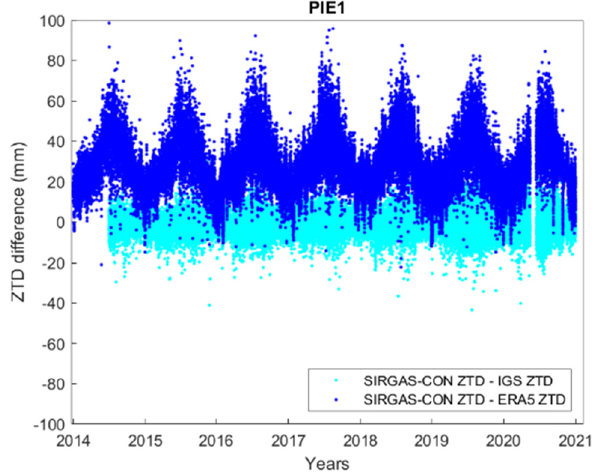
Figure 10: SIRGAS - CON ZTD and ERA5 ZTD ( blue ) and SIRGAS - CON ZTD and IGS ZTD ( cyan ) di ff erences for station